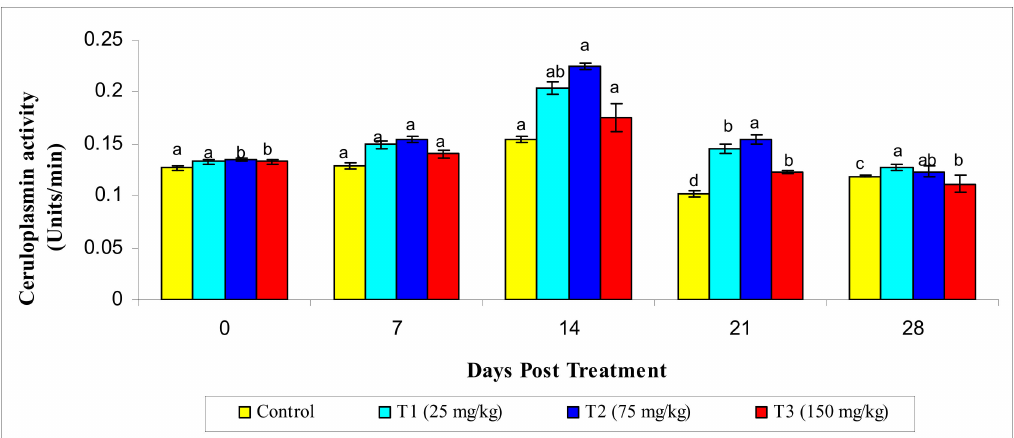
Figure 4. Ceruloplasmin activity under di ff erent treatments administered with various levels of methanol extract of Chaetomorpha antennina in Labeo rohita during post treatment days (values are mean ± SE). a,b,c,d Mean values with di ff erent superscripts considered as statistically di ff erent ( p < 0.05); n = 6 for each treatment group.